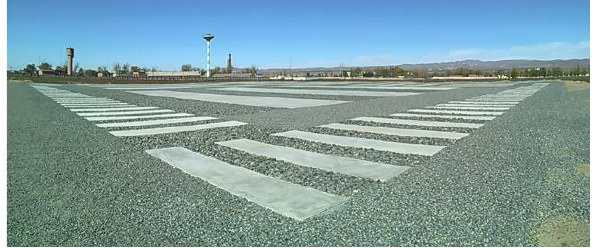
Figure 5. Bar-pattern permanent target